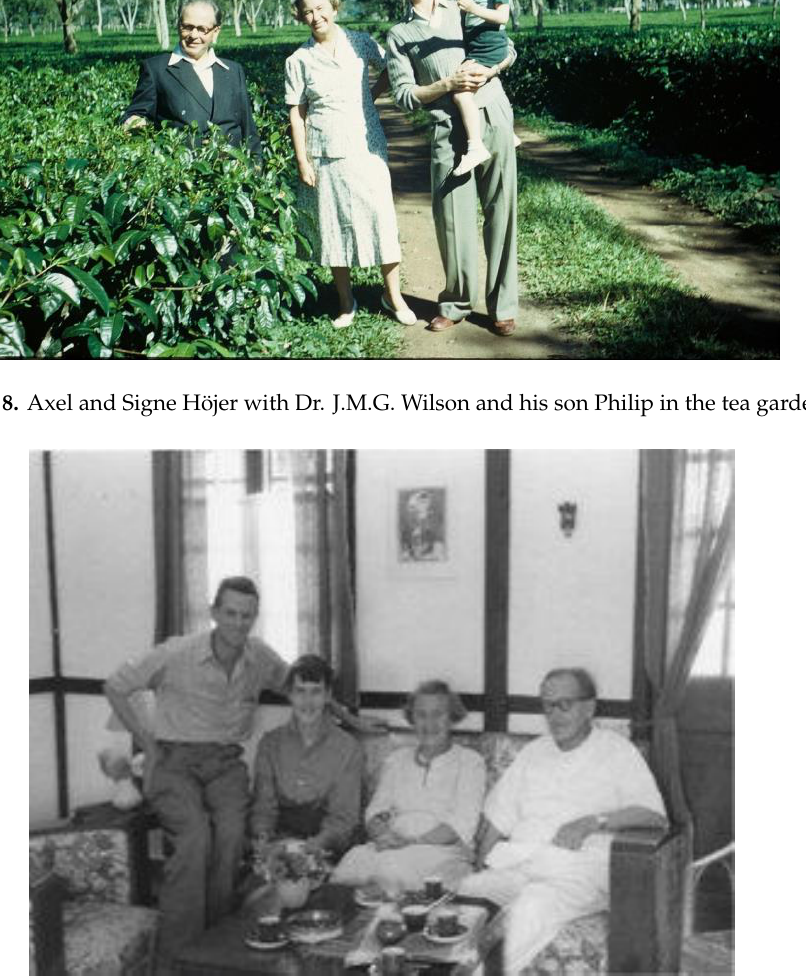
Figure 9. Dr. J.M.G. Wilson with his niece Mary and Signe and Axel Höjer taking tea together in the Principal Medical Officer’s house.